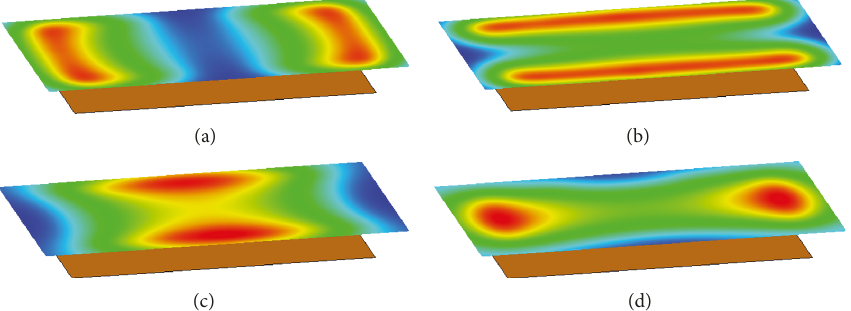
Figure 3: Normalized near- fi eld map of the fi rst two modes at 2.5GHz for the rectangular metal plate: (a) electric fi eld of mode 1, (b) electric fi eld of mode 2, (c) magnetic fi eld of mode 1, and (d) magnetic fi eld of mode